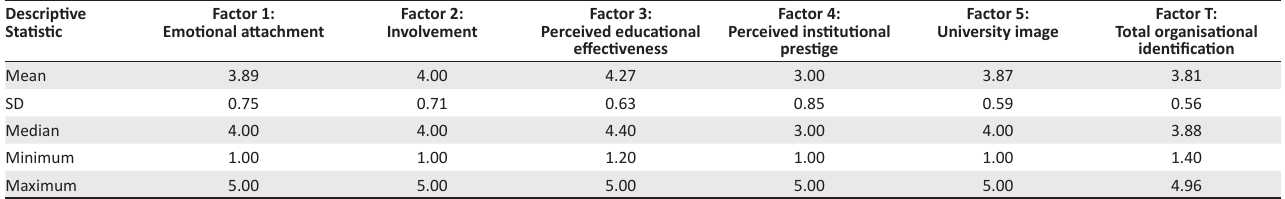
TABLE 3: The descriptive statistics for each of the five factors and Factor T. Descriptive Statistic